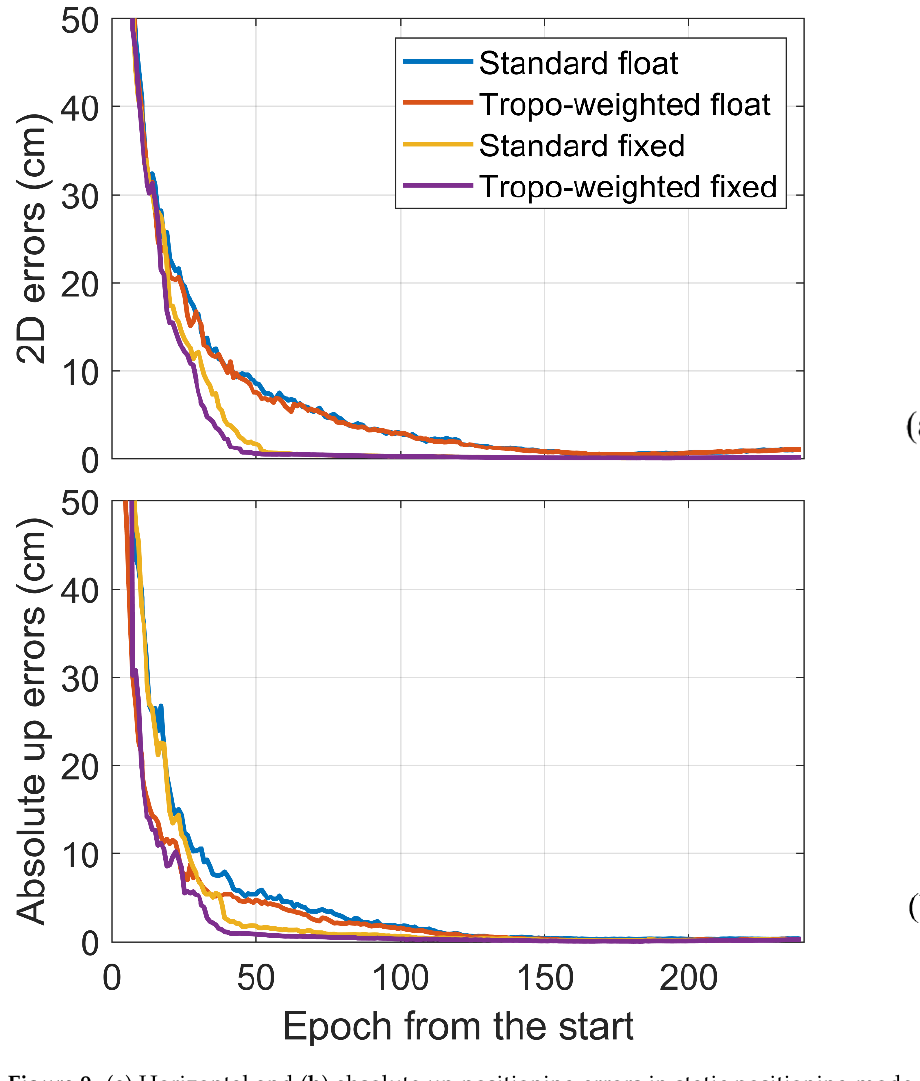
Figure 9. ( a ) Horizontal and ( b ) absolute up positioning errors in static positioning mode at each epoch from the start with 90% probability . Table 5. Summary of the convergence times to achieve 10 cm positioning accuracy of the standard and tropospheric-weighted model with 90% probability in static positioning mode (the unit is minutes; values in brackets denote the convergence times to achieve 5 cm positioning accuracy).